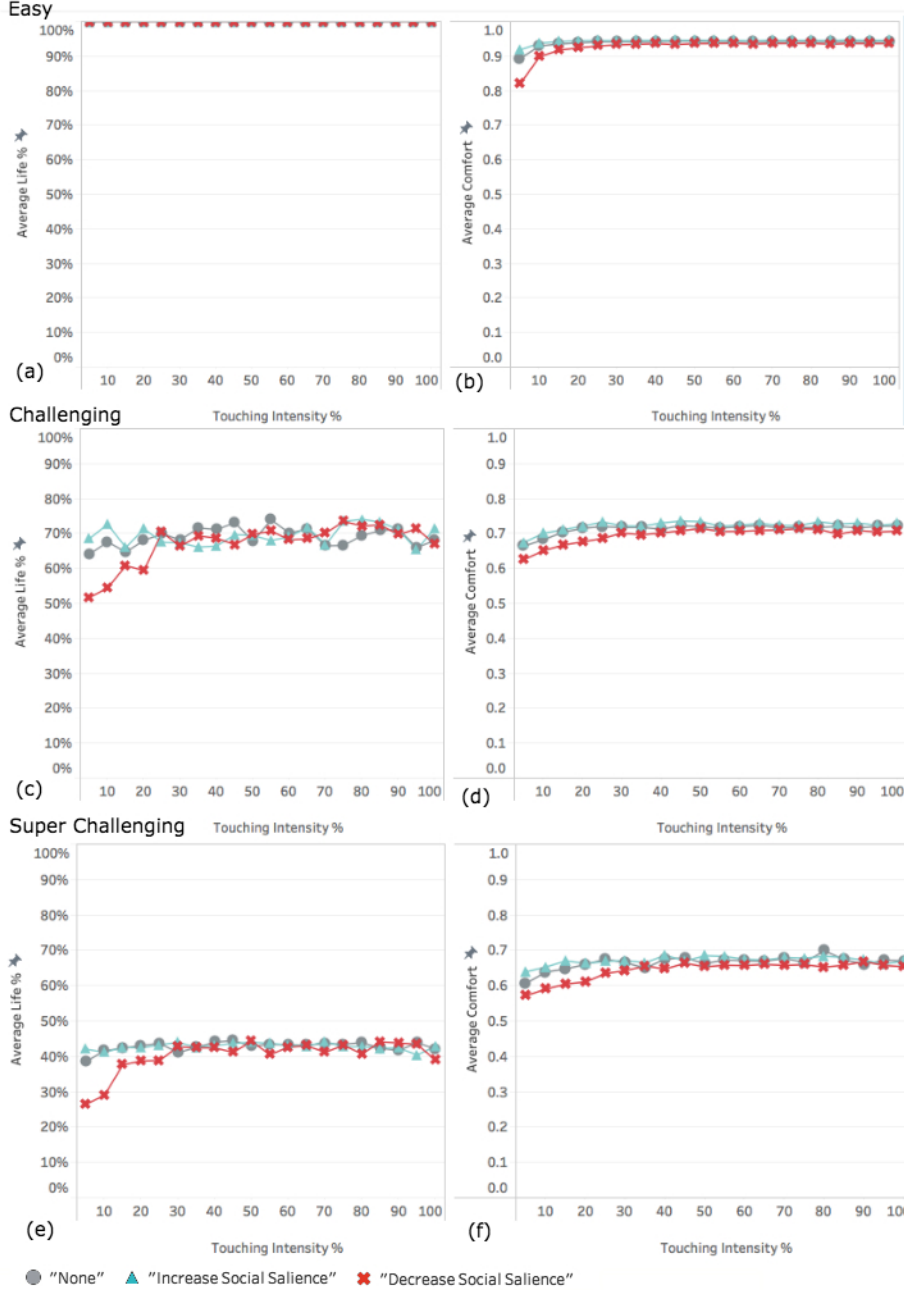
Figure 3. Results of experiment 1, showing the Average Life Length and Comfort Levels across all initial values of touchingIntensity . This experiment did not involve dynamic modulation by OT , only modulation of Social Salience using fixed, static values. Groups with no social salience (E0, C0, S0) are represented by a grey line, groups with increased social salience (E+, C+, S+) are represented by a blue line, and groups with decreased social salience (E − , C − , S − ) are represented by a red line. ( a ) Average life length across Easy (E) conditions. ( b ) Average comfort levels across Easy (E) conditions. ( c ) Average life length across Challenging (C) conditions. ( d ) Average comfort levels across Challenging (C) conditions. ( e ) Average life length across Super Challenging (S) conditions. ( f ) Average comfort levels across Super Challenging (S)